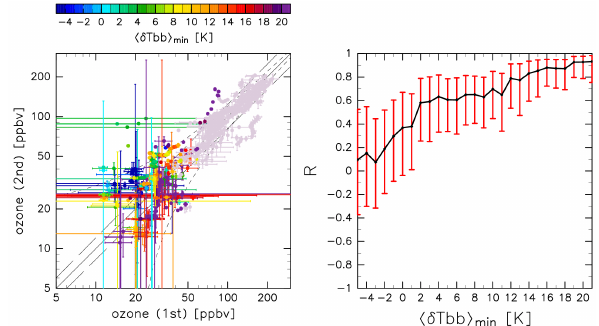
Fig. A4. Examination of convective penetration for the match pairs. Left: Scatter plot of the first versus the second ozone mixing ra- tios for preliminary matches that passed the screening for “rep- resentativeness of match air parcel” color-coded by the value of < δT bb > min (see text for details). Right: Dependency of correla- tion coefficients for ozone mixing ratios between the first and sec- ond observations on the value of < δT bb > min . The error bars are 99% confidence